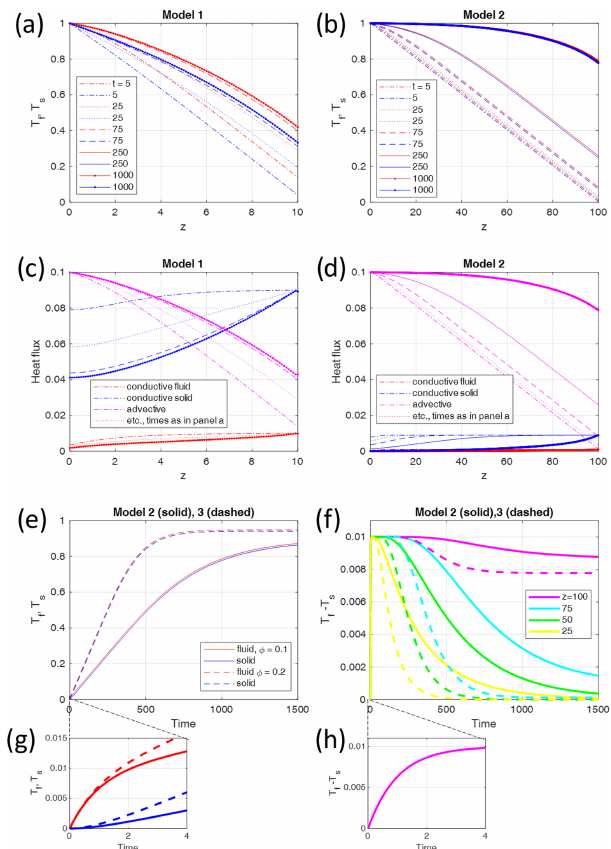
Figure 2. Typical model evolution for Pe = 1, two different melt fractions φ , and two different non-dimensional temperature gradi- ents G (i.e., heights H ). (a) Model 1 is with G = 0 . 1 ( H = 10) and φ = 0 . 1. Red and blue curves show the fluid and solid tem- peratures at different non-dimensional times t as indicated by the legend, respectively. Initial temperatures are almost identical to the t = 0 . 5 curves. Steady state is reached at about t = 100; the curves of the last two times plot on each other. (b) Model 2 with G = 0 . 01 ( H = 100), otherwise as in (a) . Steady state is not fully reached. (c) Conductive (blue and red curves) and advective (magenta curve) heat fluxes through the solid and fluid, respectively, of model 1. Line styles indicate the same times as in (a) . (d) Same as (c) but for model 2. (e) Temporal evolution of fluid and solid temperatures, T f (red) and T s (blue), respectively, at the top of model 2 with φ = 0 . 1 and model 3 with φ = 0 . 2. G = 0 . 01 ( H = 100) for both models. (f) Evolution of fluid–solid temperature difference ( T f − T s ) at dif- ferent distances z in model 2 ( φ = 0 . 1, solid curves) and in model 3 ( φ = 0 . 2, dashed curves). (g) Zoomed-in early temporal evolution of solid and fluid temperatures of models 2 and 3 shown in (e) . (h) Zoomed-in early temporal evolution of temperature difference of models 2 and 3 shown in (f)